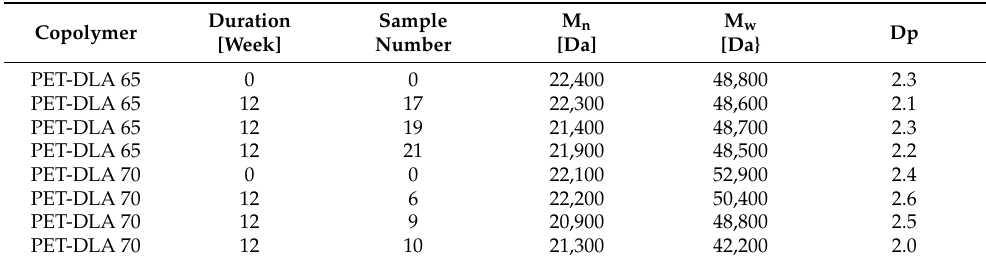
Figure 9. FTIR spectra of the studied PET-DLA 65 copolymers: sample 0-not implanted, sample 17, 19, 21 after 12-week implantation period.